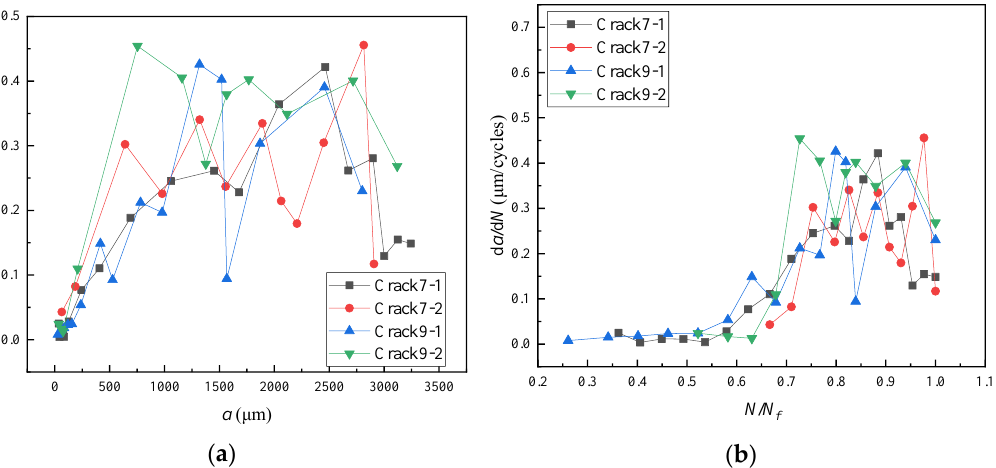
Figure 17. Variation of crack growth rate of cruciform specimen with 0° waist hole notch in the central area. ( a ) Variation of crack growth rate with crack length. ( b ) Variation of crack growth rate with cycle ratio.